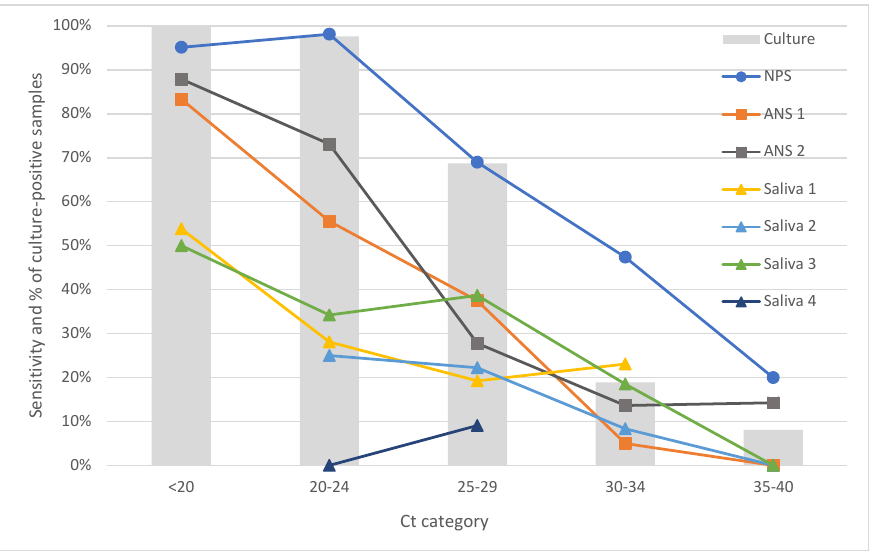
Figure 1. Sensitivities of individual tests calculated relative to qPCR as the gold standard, and presence of viable virus stratified by C t cycles; note that cell culture was performed only in 488 samples where qPCR and RAT test results differed; where the respective category included fewer than 5 patients, data are not presented in the graph. NPS–nasopharyngeal swab; ANS–anterior nasal swab; Ct–Cycle threshold.